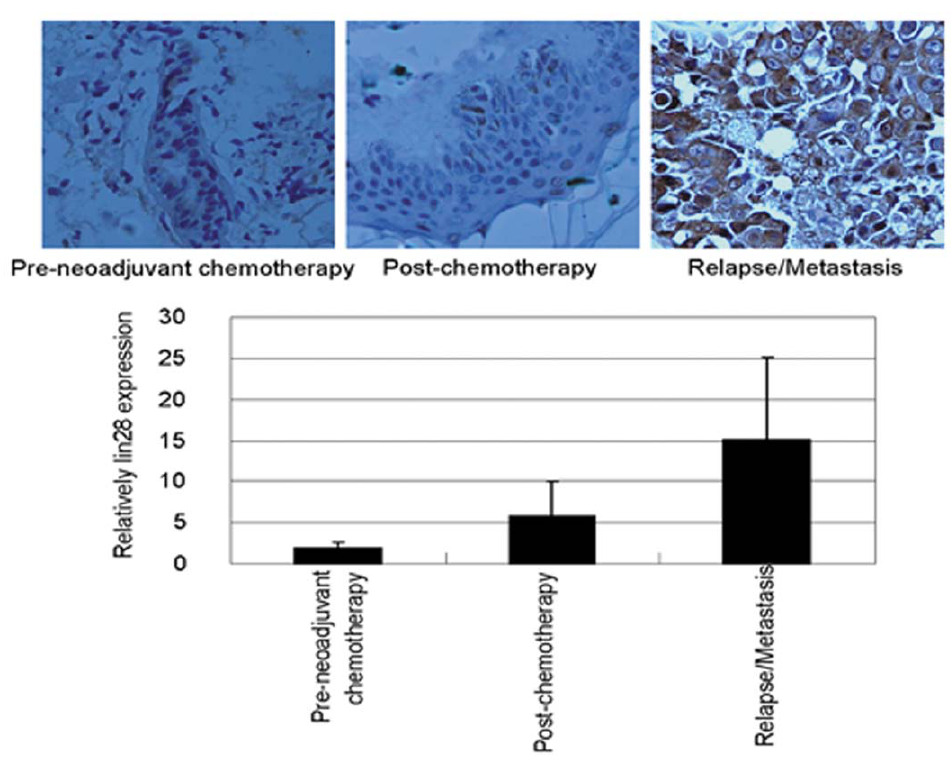
Figure 4. Lin28 is highly expressed in post-neoadjuvant and relapse or metastasis tumor tissues. The expression of Lin 28 in tumor tissues was determined by